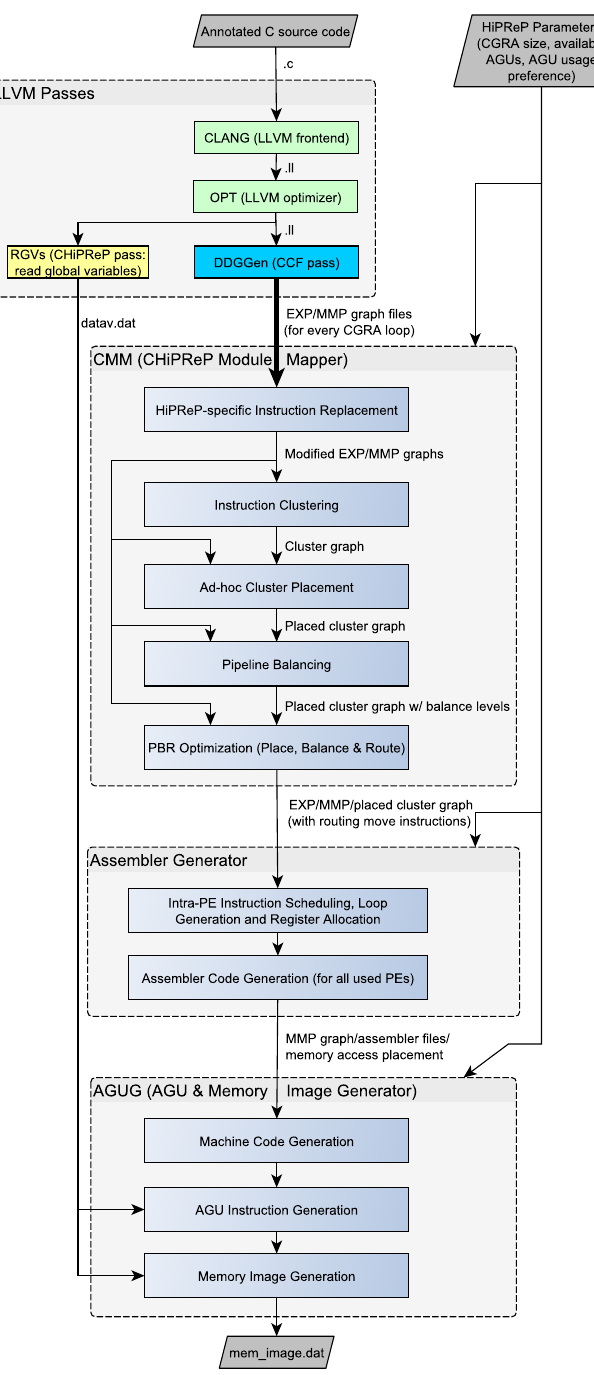
Figure 2. CHiPReP Compilation